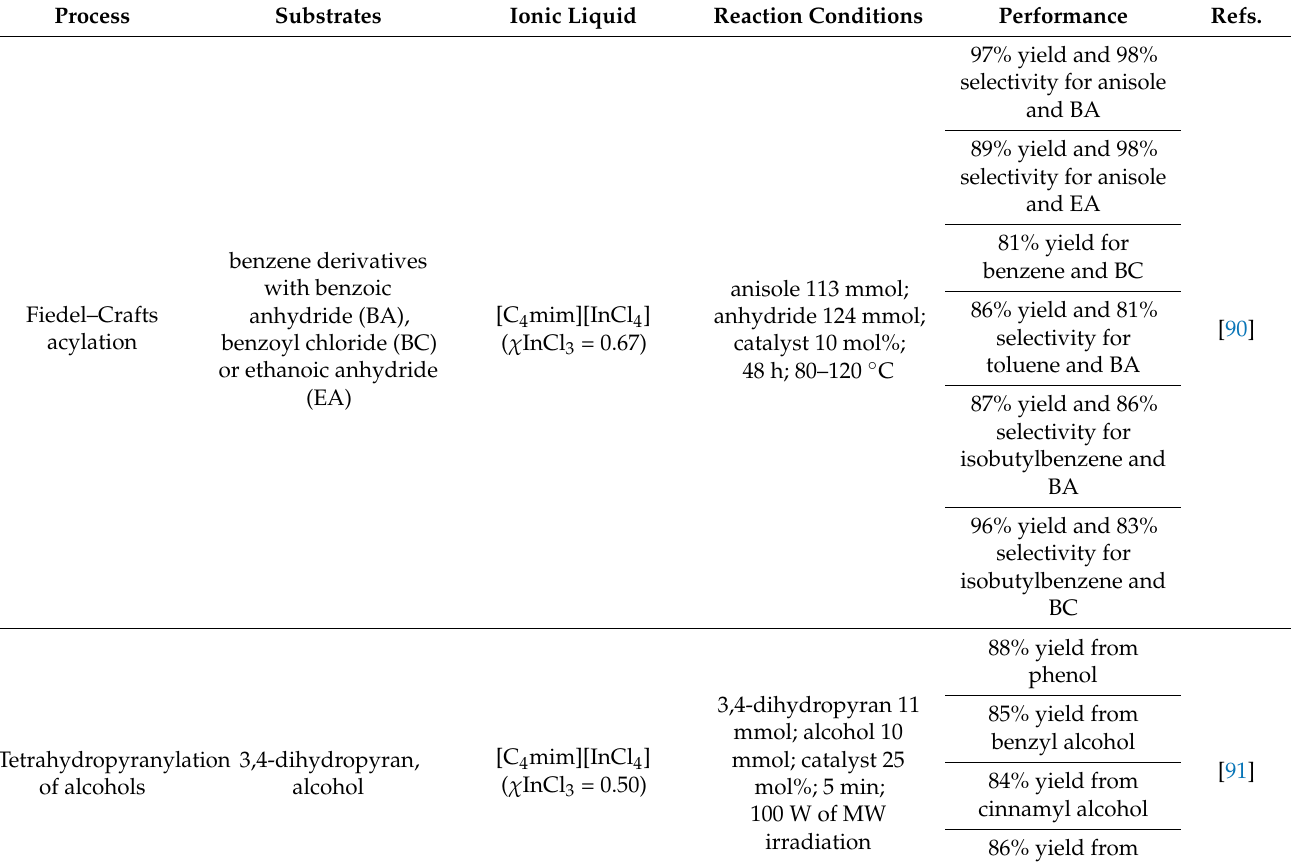
Table 4. Summary of reactions catalysed by indium(III)-based ILs. Process Substrates Ionic Liquid Reaction Conditions Performance